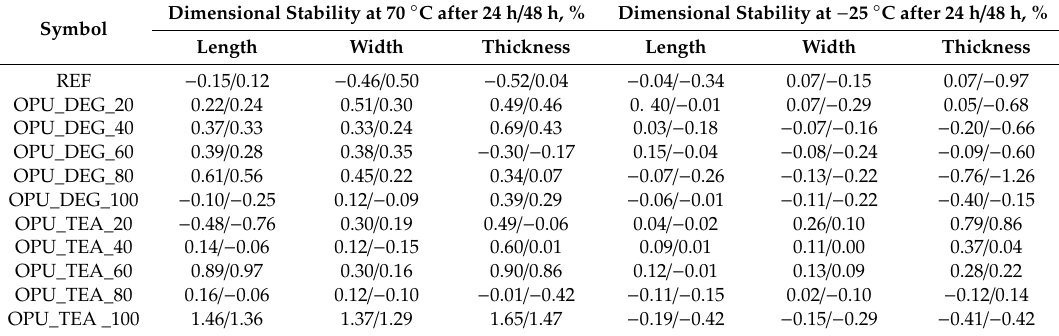
Table 4. Dimensional stability of foams measured at 70 °C and − 25 °C.